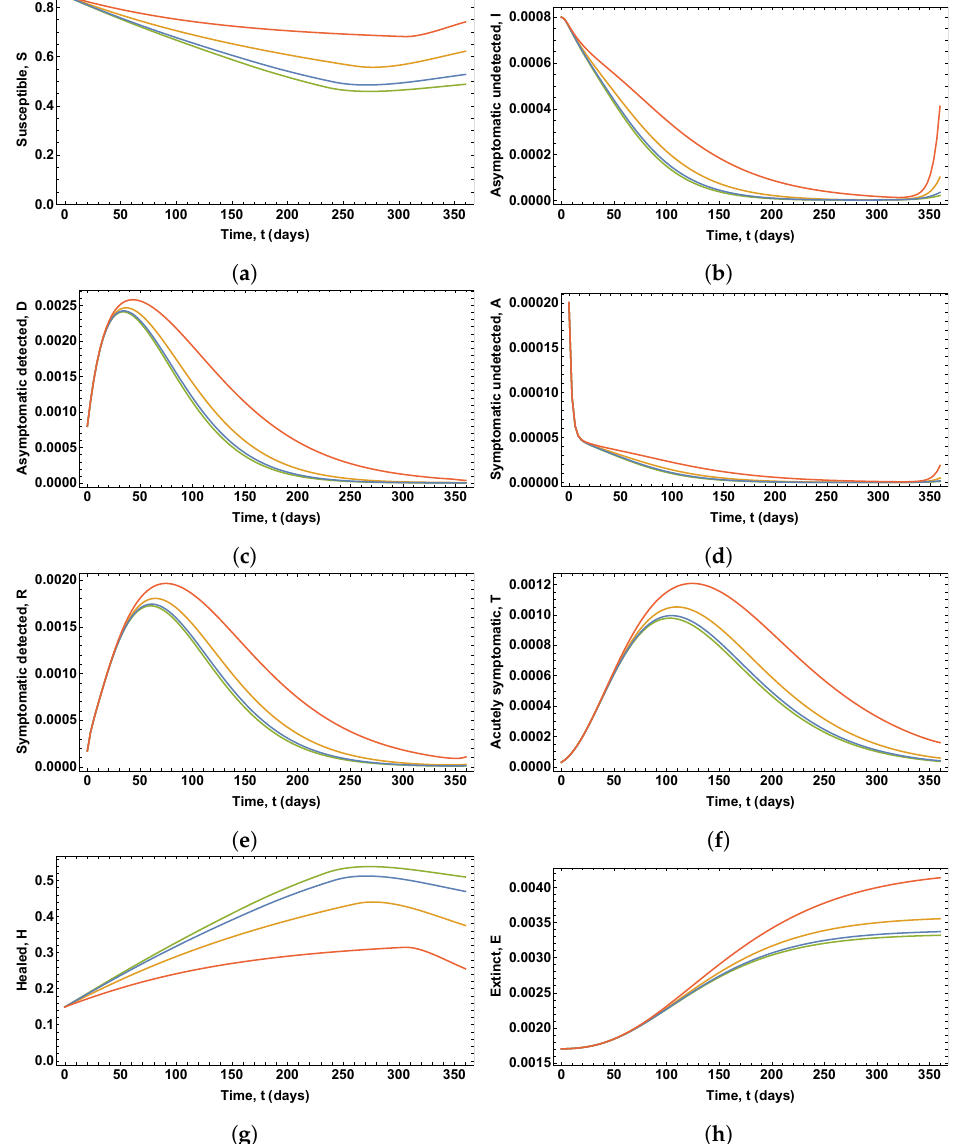
Figure 15. Proportions of people in each compartment obtained assuming immunity loss rates ι = 0.0056 (red), ι = 0.0028 (orange), ι = 0.0014 (blue), and ι = 0.0009 (green): ( a ) Susceptible people. ( b ) Asymptomatic undetected people. ( c ) Asymptomatic detected people. ( d ) Symptomatic undetected people. ( e ) Symptomatic detected people. ( f ) Acutely symptomatic people. ( g ) Healed people. ( h ) Extinct